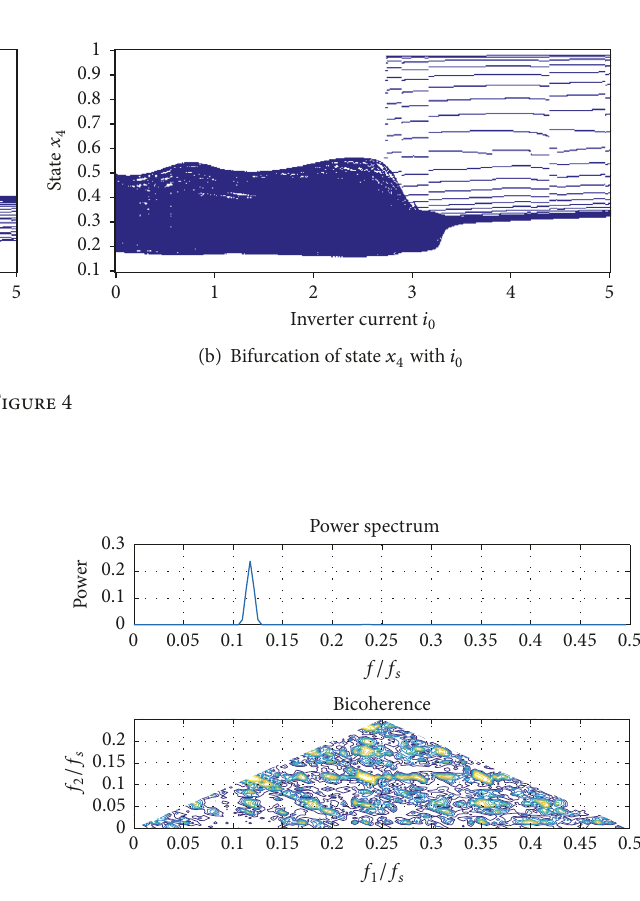
Figure 6: Contour of bicoherence of state 𝑦 for the smart grid